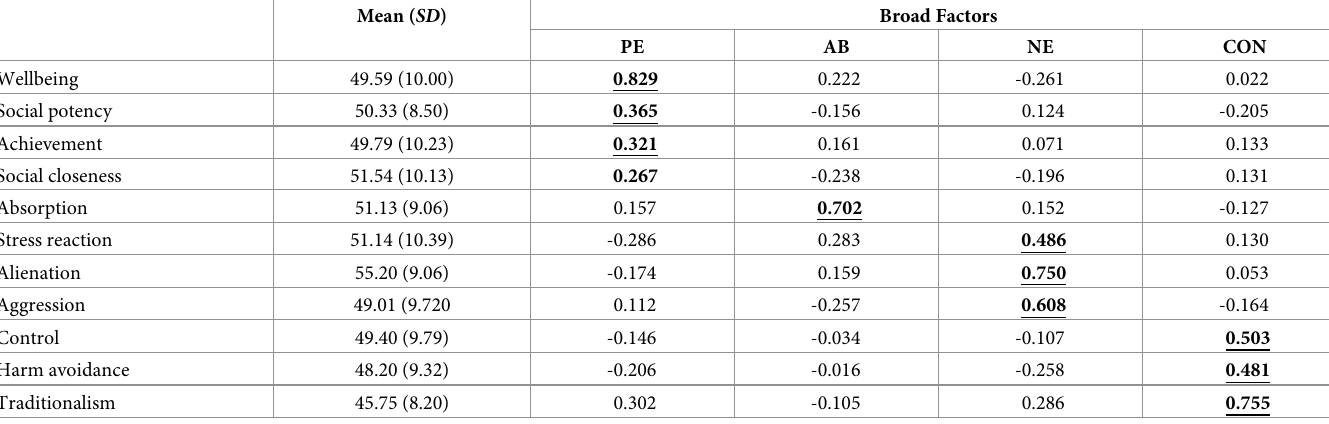
Table 1. Standardized factor loadings in the ESEM Model.